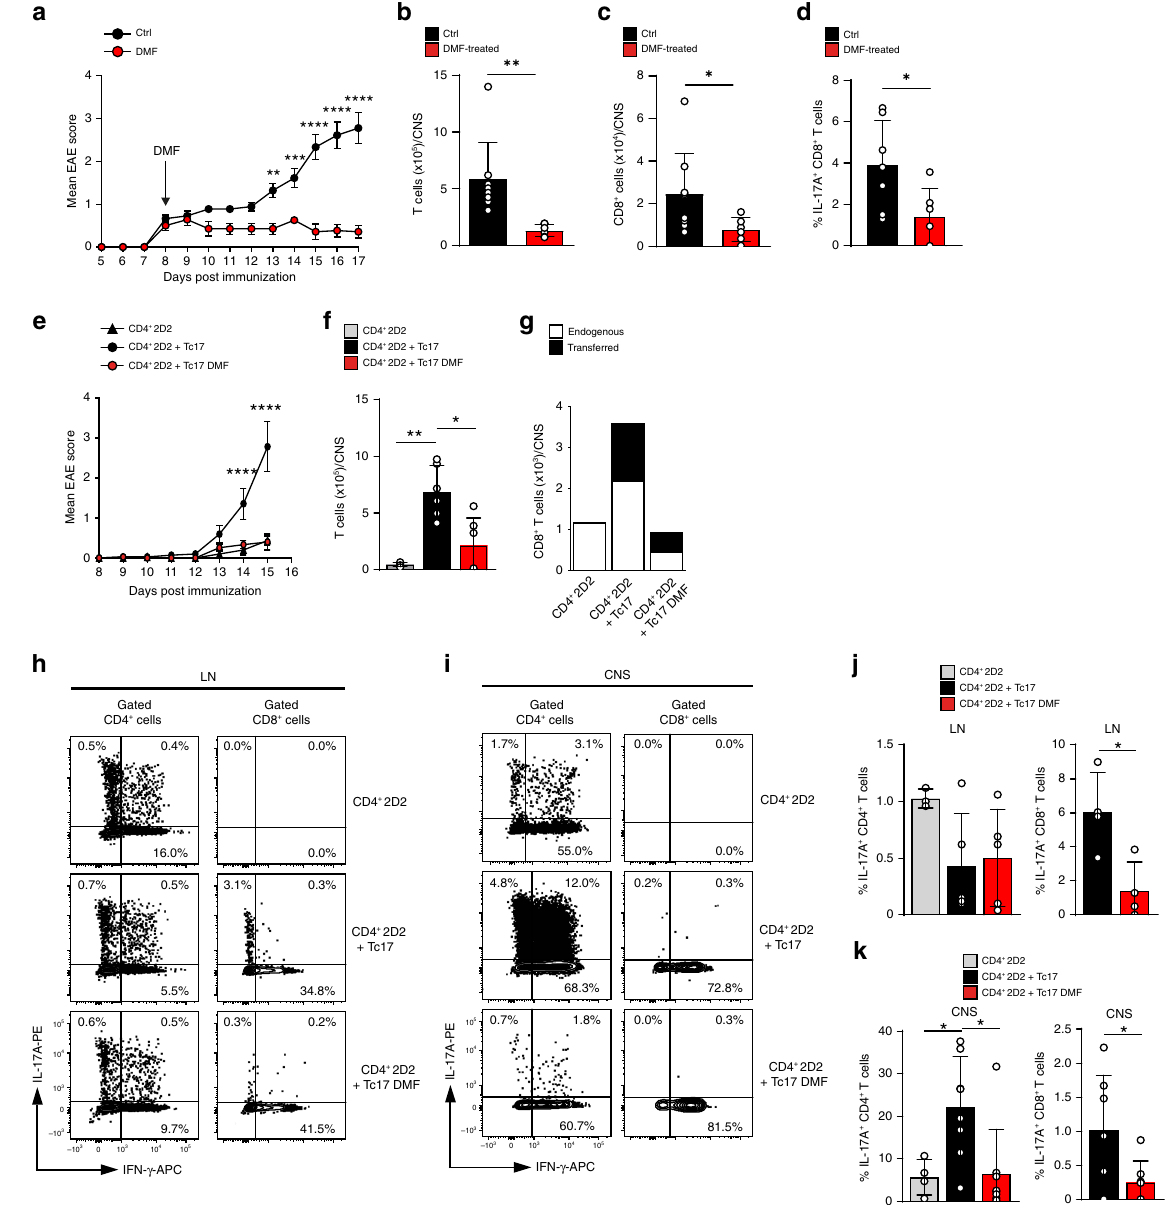
Fig. 6 DMF restricts CNS autoimmunity by limiting the co-pathogenic function of Tc17 cells. a Mean clinical scores (±s.d.) of MOG 35 – 55 immunized wild- type (WT) mice ( n = 7) with therapeutic DMF application, starting from day 8, indicated by arrow. b T cell numbers (mean±s.d.; n = 7) in the CNS of WT mice ±DMF treatment. c CD8 + T cell numbers (mean±s.d.; n = 7) in the CNS of WT mice±DMF treatment. d Percentages of IL-17A + CD8 + T cells (mean±s.d.; n = 7) in the CNS of WT mice±DMF treatment. e Mean clinical scores (±s.d.) of MOG Irf4 − / − ( n = 7) mice receiving 10 3 CD4 + 2D2 T cells 35 – 55 immunized alone or together with 2.5×10 6 in vitro differentiated Tc17±DMF. Signi fi cances in graph are shown for 2D2 + Tc17 vs 2D2 + Tc17 DMF. f T cell numbers (mean±s.d., n = 4 – 6) in CNS of Irf4 − / − mice after CD4 + 2D2 T and Tc17±DMF co-transfer. g Endogenous to transferred CD8 + T-cell ratio (mean, n = 5) in CNS of Irf4 − / − mice after CD4 + 2D2 T and Tc17±DMF co-transfer. h , i Flow cytometry of IL-17A and IFN- γ in gated CD4 + and CD8 + T cells in LN h or CNS i of Irf4 − / − mice after CD4 + 2D2 T and Tc17±DMF co-transfer. j , k Percentages of IL-17A + CD4 + or IL-17A + CD8 + T cells (mean±s.d.) in LN ( n = 4 – 5) j and CNS ( n = 7 – 8) k of Irf4 − / − mice; b , c , d , f , j , k individual values are plotted. In a , e ** p <0.01, *** p <0.001, **** p <0.0001 evaluated by two-way ANOVA with Bonferroni post-hoc test, in ( d , j , for CD8 + T cells) * p <0.05 by two-tailed, unpaired t -test, in ( b , c , k for CD8 + T cells) * p <0.05, ** p <0.01 by two-tailed, unpaired t -test with Welch ’ s correction, in ( j , k for CD4 + T cells) * p <0.05, ** p <0.01 by one-way ANOVA followed by Dunnett multiple comparison test, in f * p <0.05, ** p <0.01 by one-way Welch ’ s ANOVA with Games – Howell multiple comparison